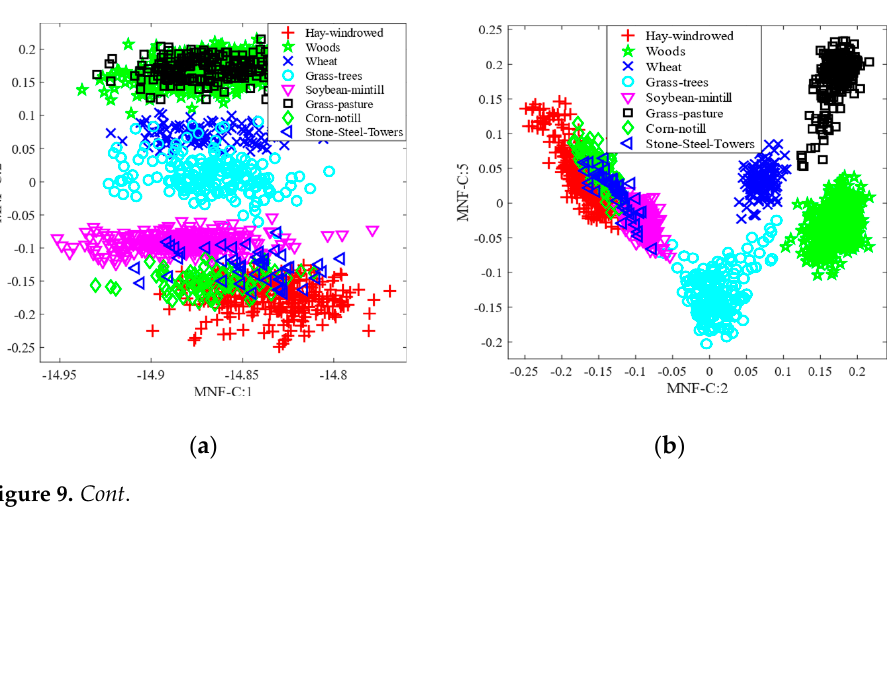
99.44 Table 15. Classification performance measure (%) on the ROSIS PU HSI for different